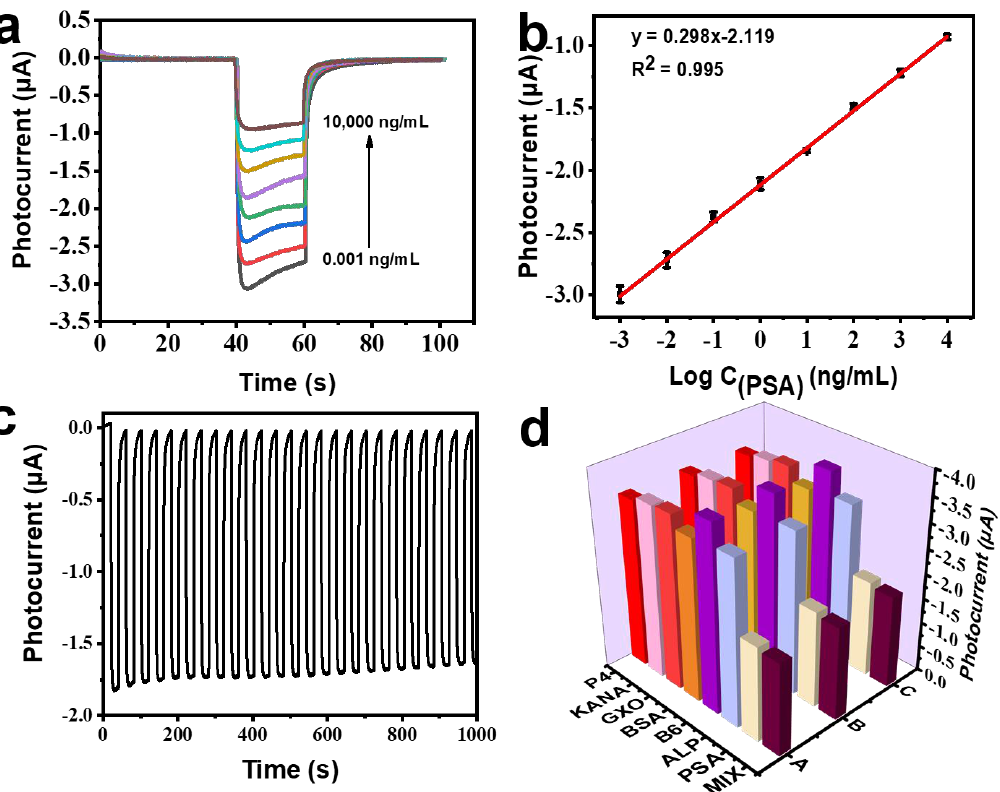
Figure 4. ( a ) Photocurrent responses of the fabricated PEC sensor after incubation with different concentrations of PSA in 0.1 M Tris − HCl (pH 7.4). ( b ) Calibration curve for PSA on the PEC sensor. ( c ) Stability of the photocurrent response in repeated on/off irradiation with an interval of 20 s. ( d ) Evaluation of the specificity of the PEC sensor for interfering substances. Note that P4, KANA, GXO, BSA, B6, ALP, and PSA represent the photocurrent intensities of fabricated PEC sensors with the addition of 10 μM P4, 10 μM KANA, 10 μM GXO, 10 μM BSA, 10 μM B6, 10 μM ALP, and 10 ng/mL PSA, in 0.1 M Tris − HCl buffer, respectively. MIX represents the photocurrent intensity of the fabri- cated PEC sensor with the addition of all the above substances. A, B, and C represent three sets of mutually independent experiments.